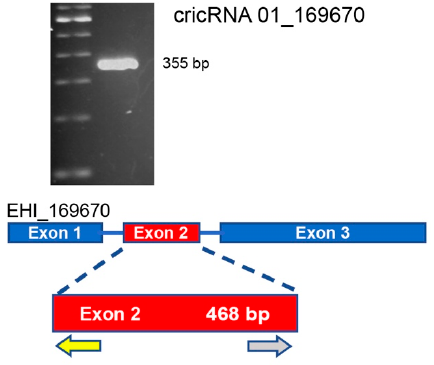
Figure 4. RT-PCR amplification of circRNA 01_169670. The 355 bp fragment amplified corresponds to exon 2. Arrows underneath correspond to the divergent primers used in the